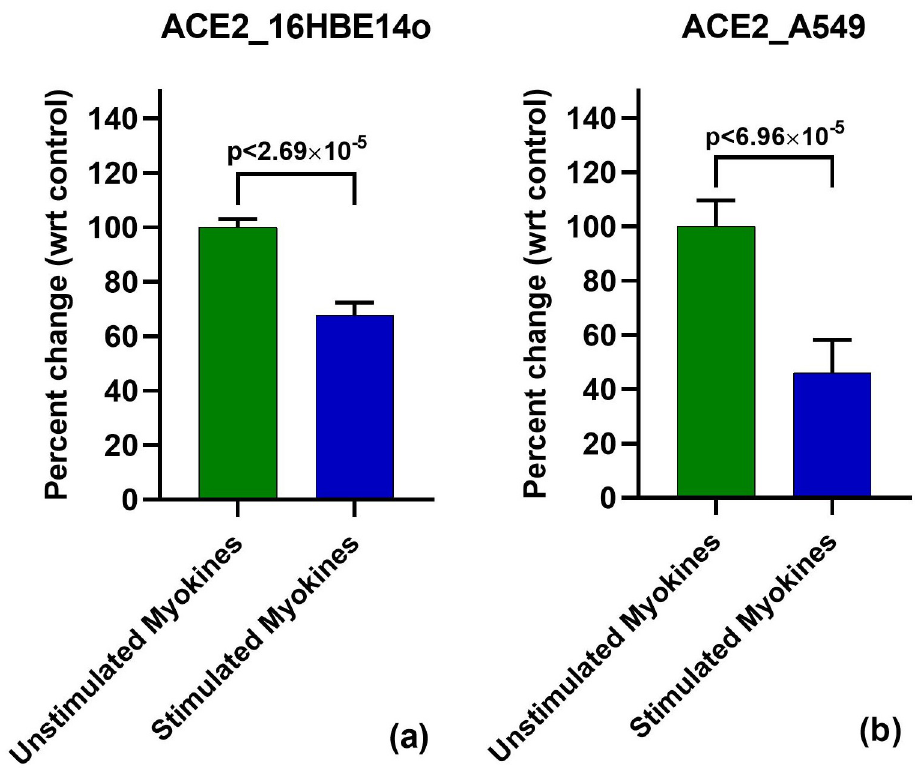
Fig 1. Downregulation of ACE2 mRNA with 48 h stimulated myokine treatment. (a): ACE2 qPCR in 16HBE14o . ACE2 mRNA was also shown to be downregulated with stimulated myokine treatment by 32.5%. (b): ACE qPCR in A549 . Stimulated myokine treatment resulted 63.9% downregulation of ACE2 gene expression.